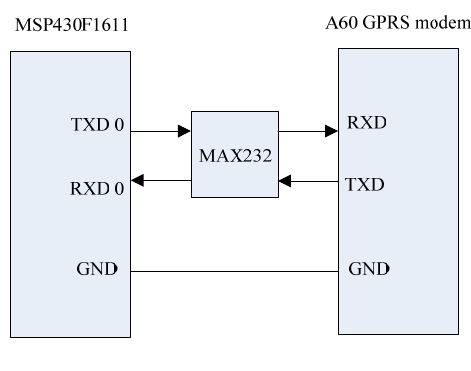
Figure 12. Interface circuit of the GPRS module.